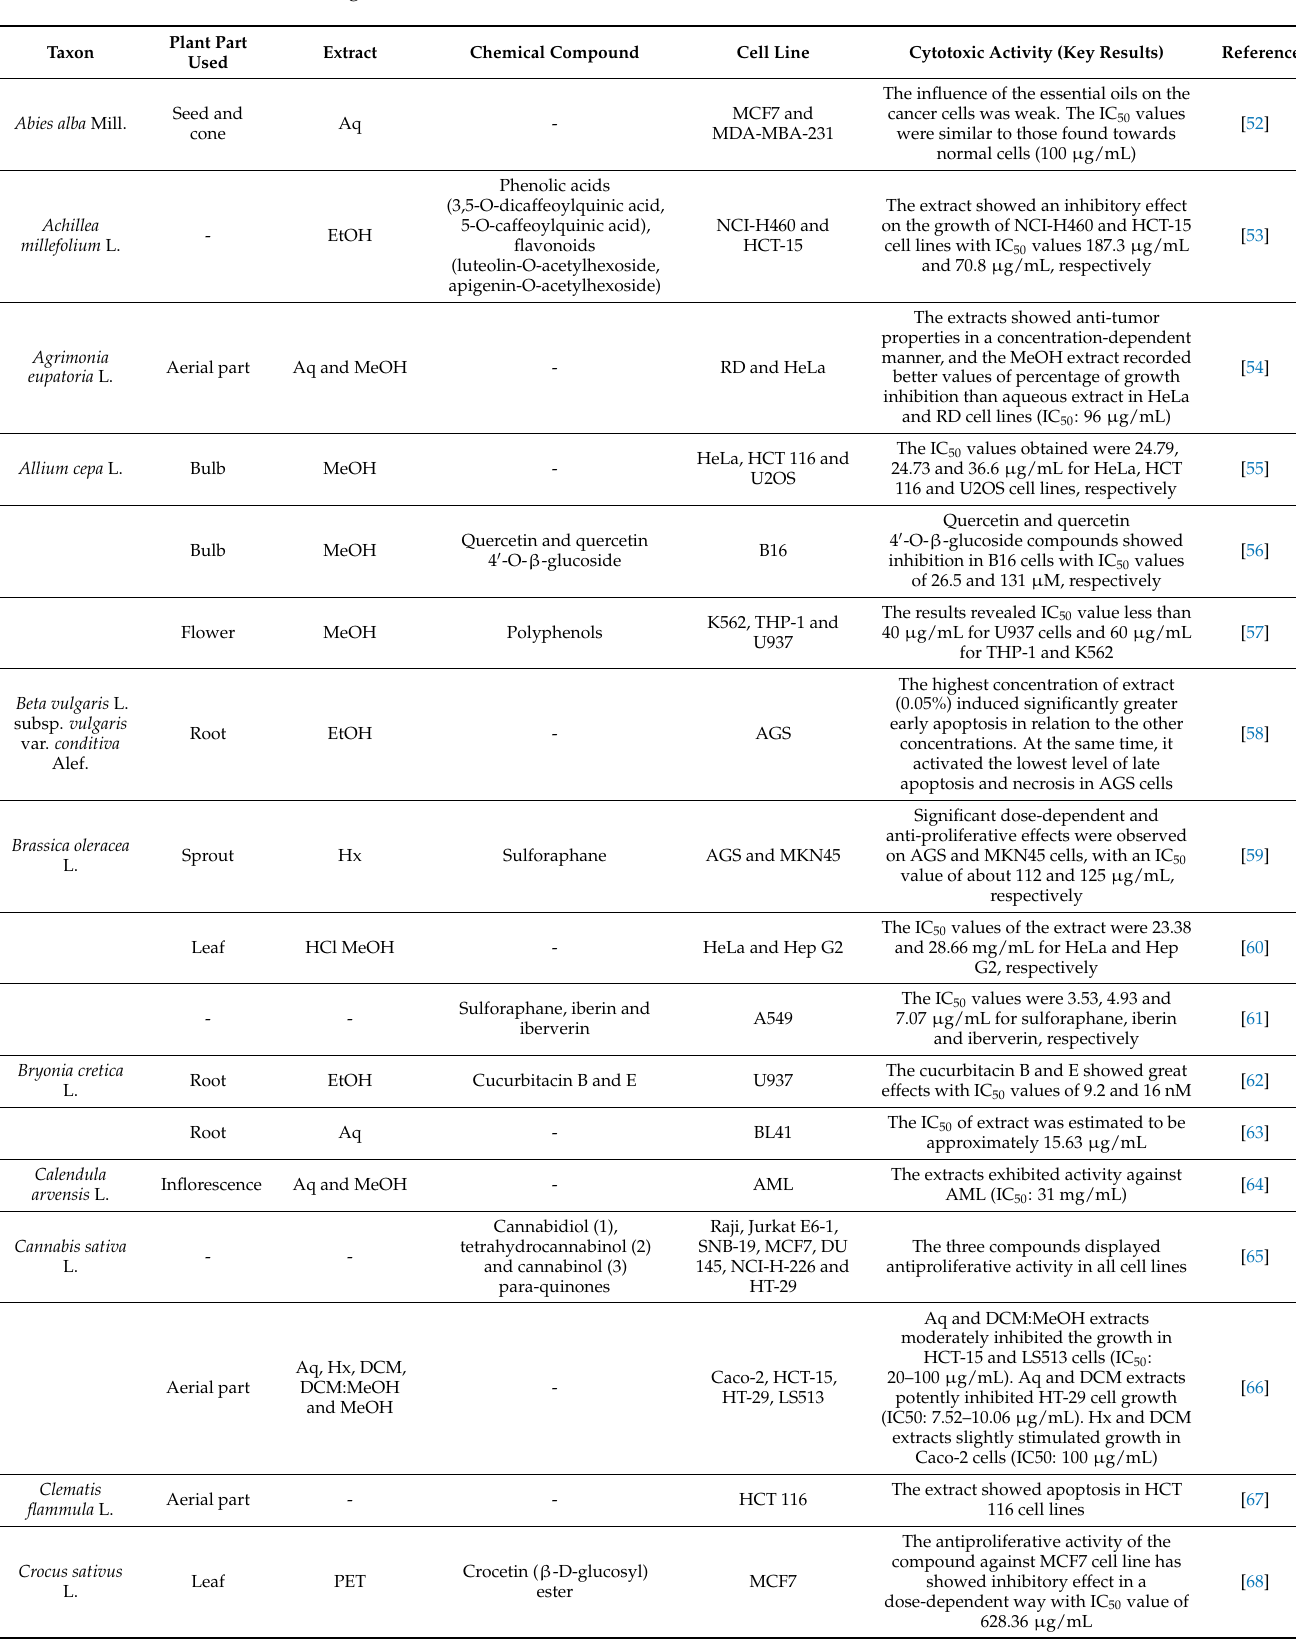
Table 2. Review of the cytotoxic activity against cancer cell lines for plants quoted in the Catalan linguistic area to treat